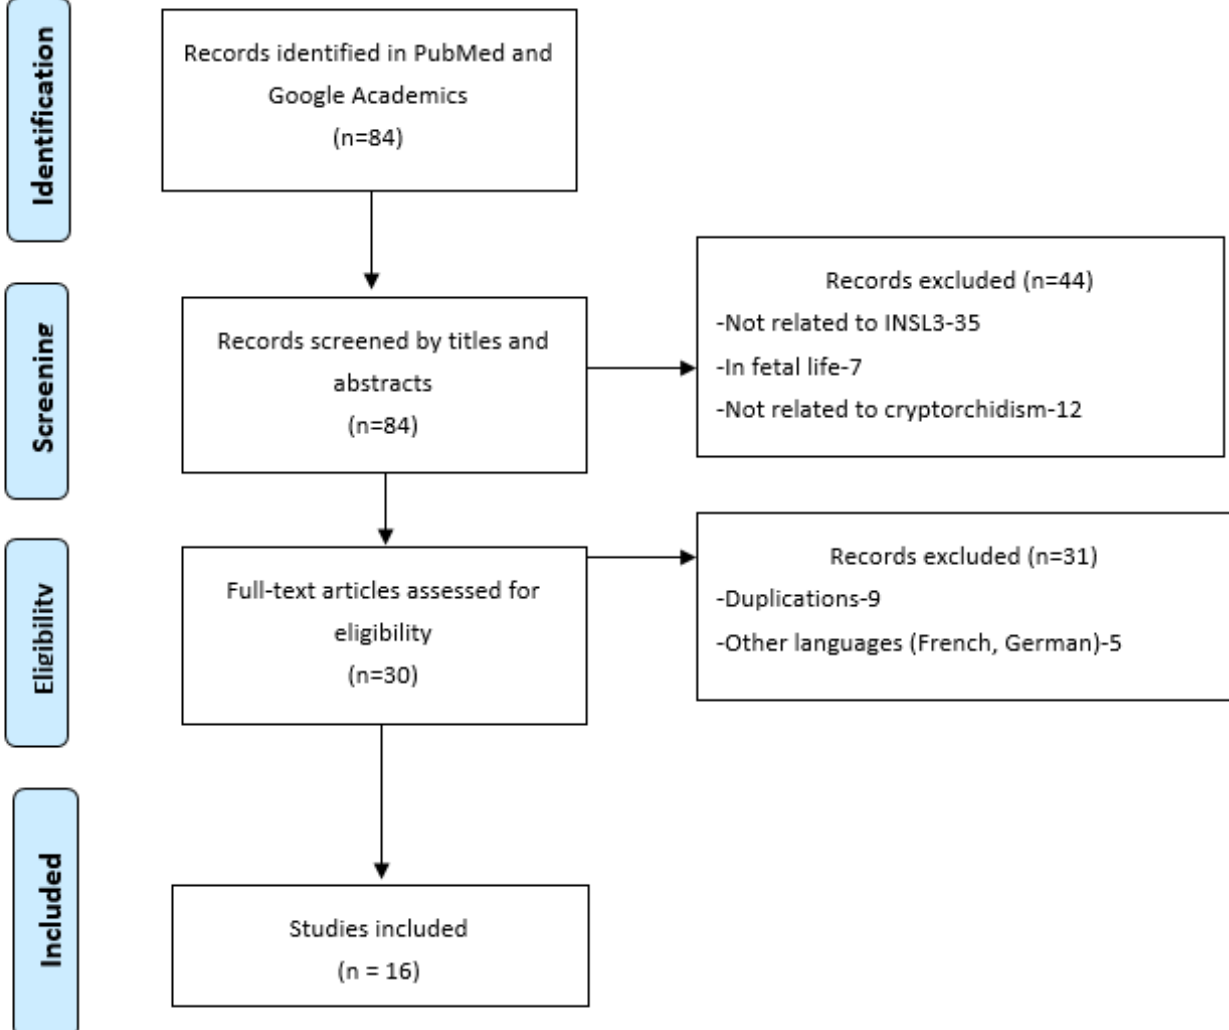
Figure 1. PRISMA flow chart for papers selection.